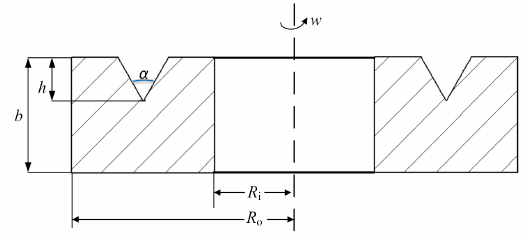
Figure 5. Conical configuration parameters.